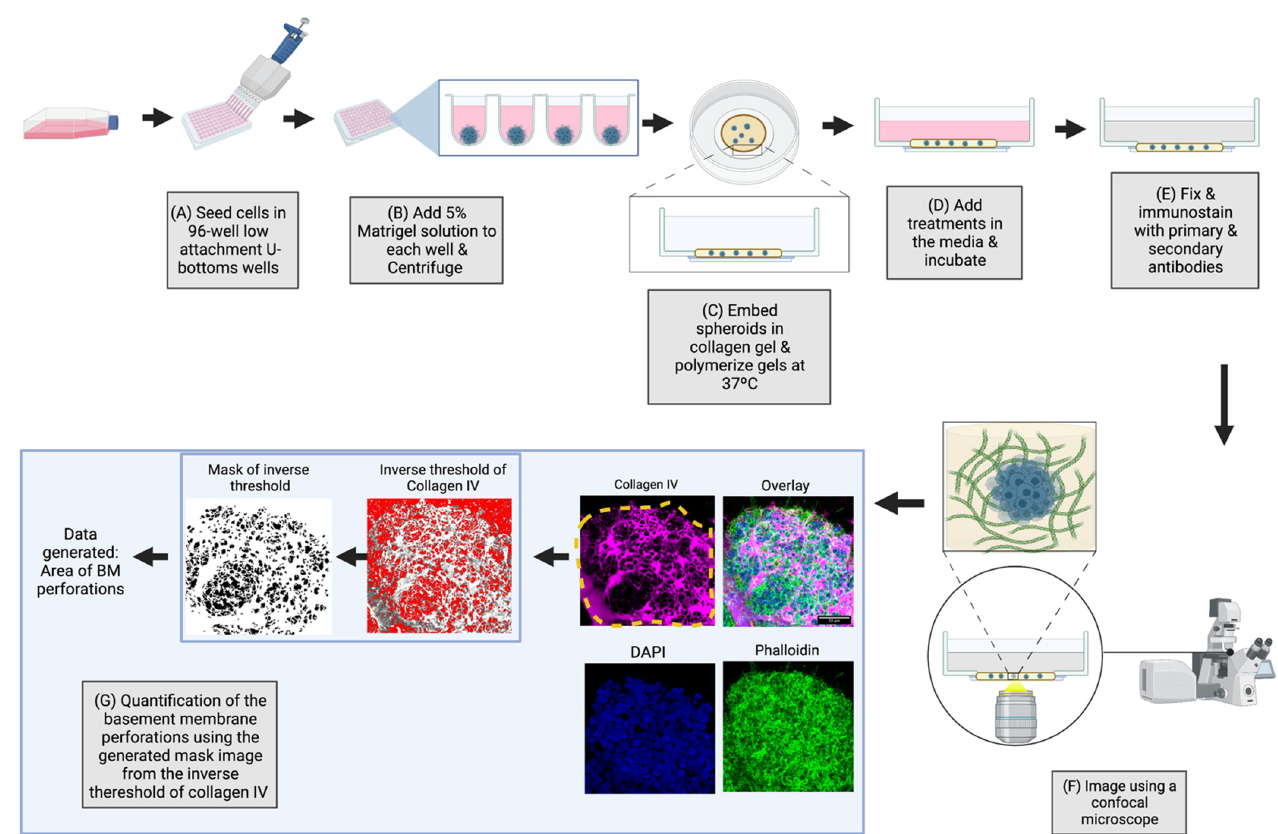
Scheme 1. Schematic illustration of the protocol for generating cancer cell spheroids encapsulated in a basement membrane and embedded in a 3D collagen gel for invasion assays. ( A ) In the spheroid generation process, cells were seeded in a 96-well, low attachment V- or U-bottom dish. To form